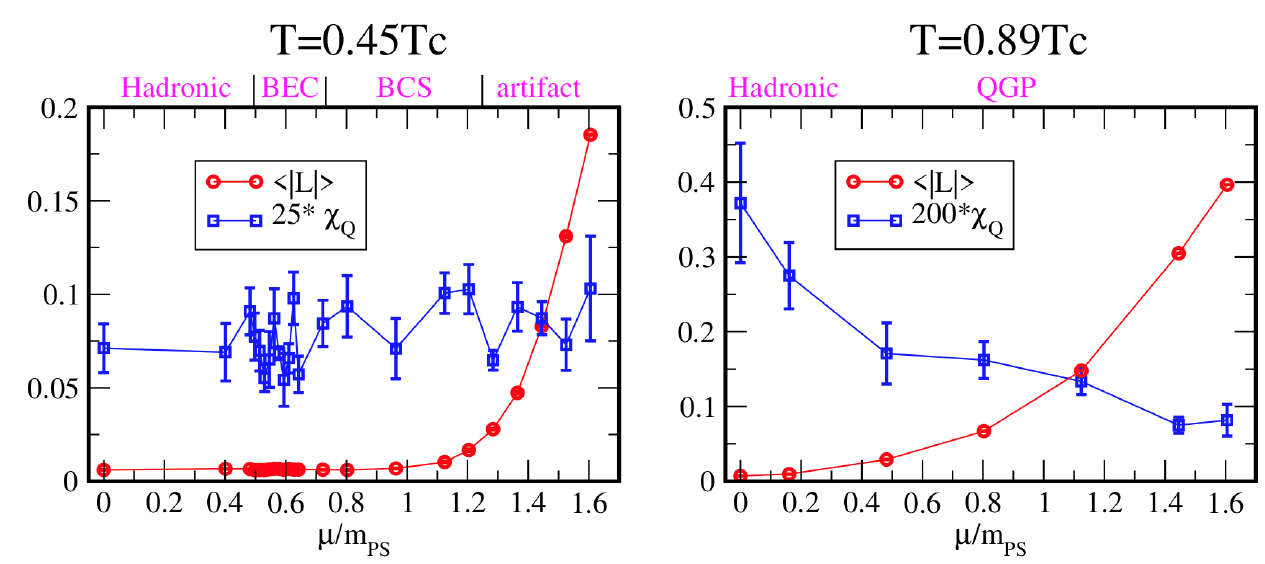
Figure 6. Polyakov loop and topological susceptibility in two-color QCD, in a cold ( left ) and in hot lattice, from Ref. [64]. We would like to highlight here the lack of sensitivity of the topological susceptibility on the threshold for the Polyakov loop at µ o at T = 0.45 T c ( left ), to be contrasted with the (anti) correlated behaviour of the same observables in the Quark-Gluon Plasma ( right ). Please note that the identification of the diquark dense phase with a BEC phase followed by a BCS one is still under debate